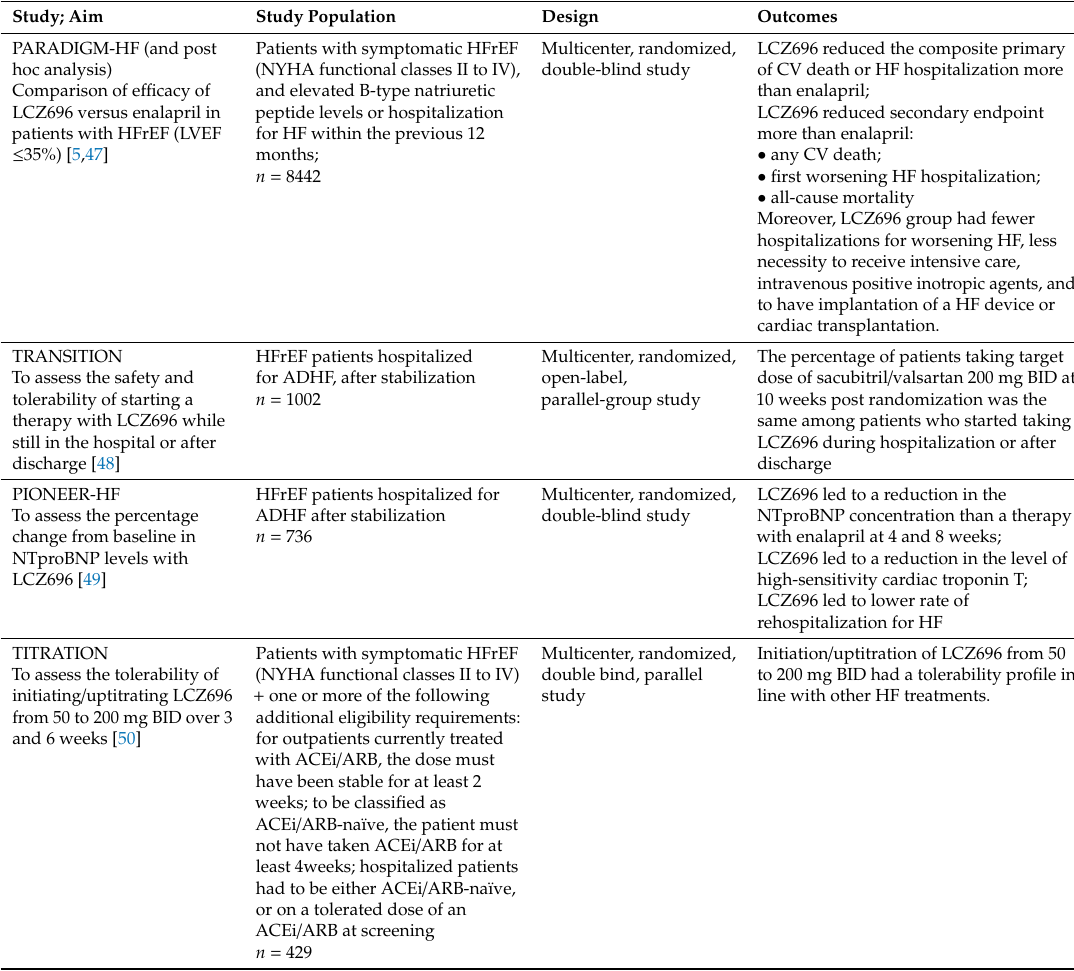
Table 1. Main clinical trials about the e ff ects of LCZ696 on cardiovascular